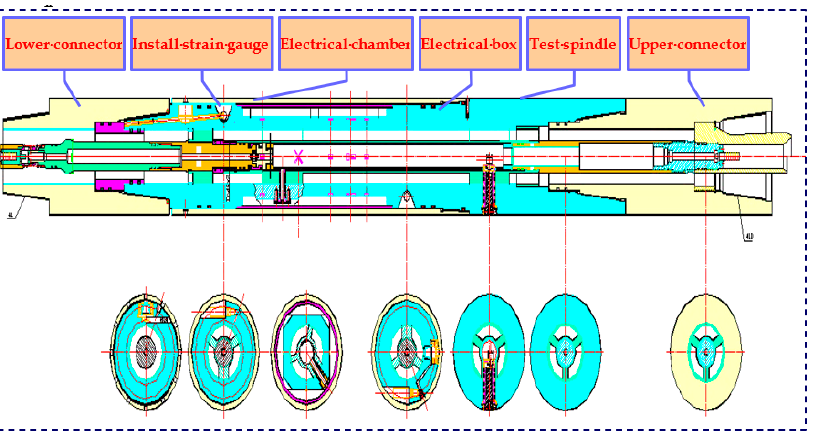
Figure 7. System mechanical structure.